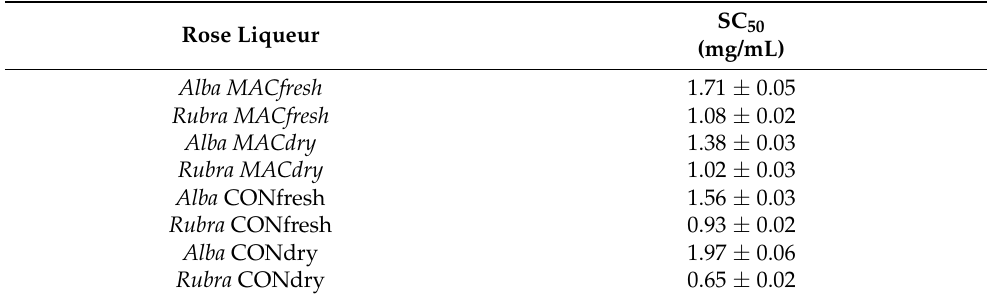
Table 5. DPPH scavenging activity of rose liqueurs from fresh and dry petals of Rosa rugosa cv. Alba and Rubra after maceration or conventional extraction.